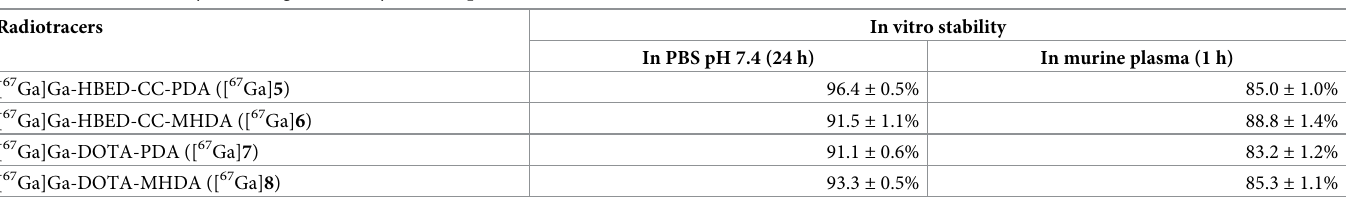
Table 2. In vitro stability for radiogallium fatty acid